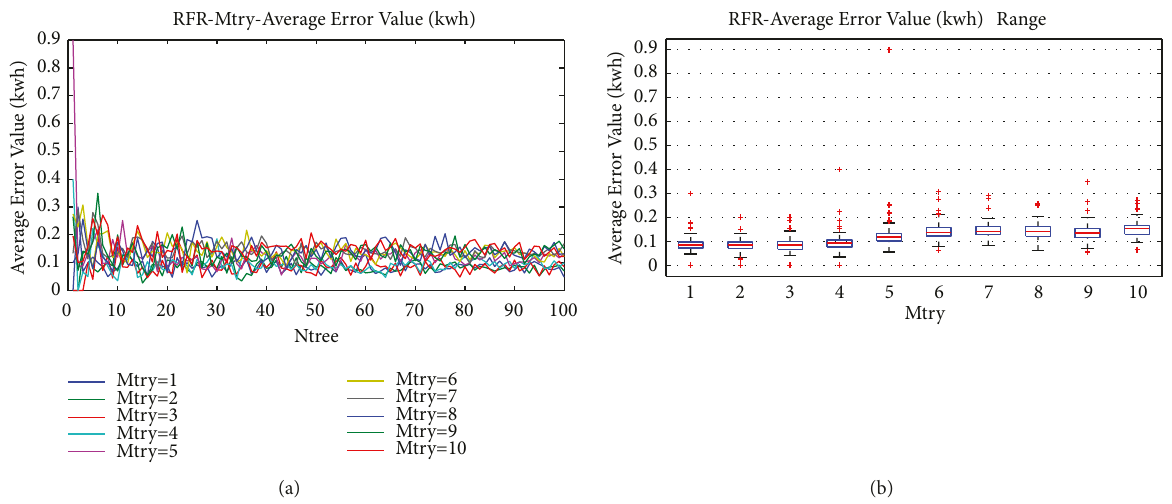
Figure 8: Convergence process and errors in RFR. (a) Errors in different Mtrys. (b) Convergence range. Importance-Distance 0.2